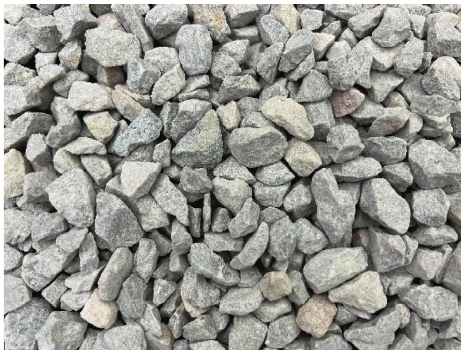
Figure 1: Schematic of subgrade rockfill